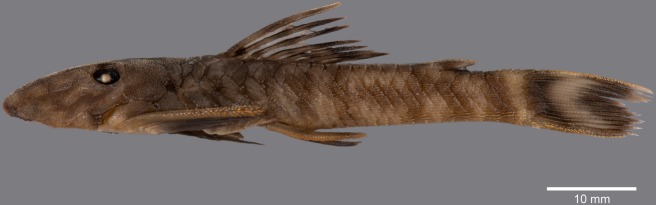
Guyanancistrus tenuis.MNHN 2002–3537, paratype, 57.4 mm SL.